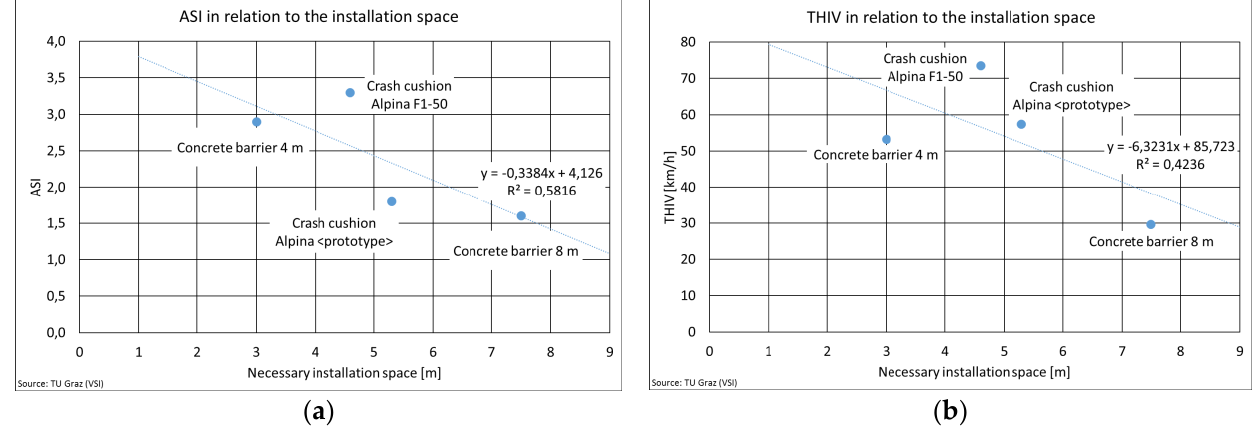
Figure 12. Relation between necessary installation space of the specific safety measure and ASI ( a ) and THIV ( b ). It can be noted that ASI and THIV are reduced with increasing installation space. Table 7. Corresponding risk of MAIS 2+ and MAIS 3+ [56] injuries of unbelted and belted occupants related to the ASI of the different safety measur.es.